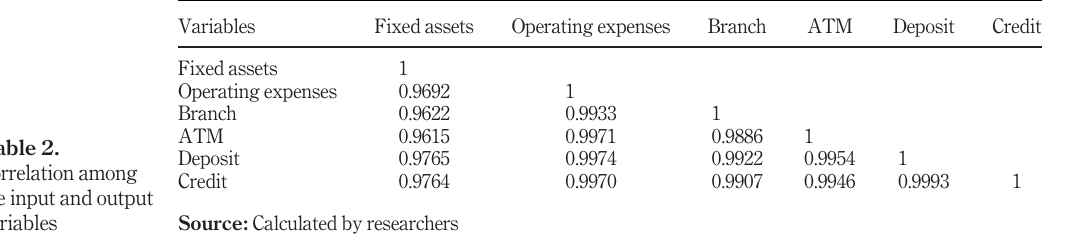
of input and output variables